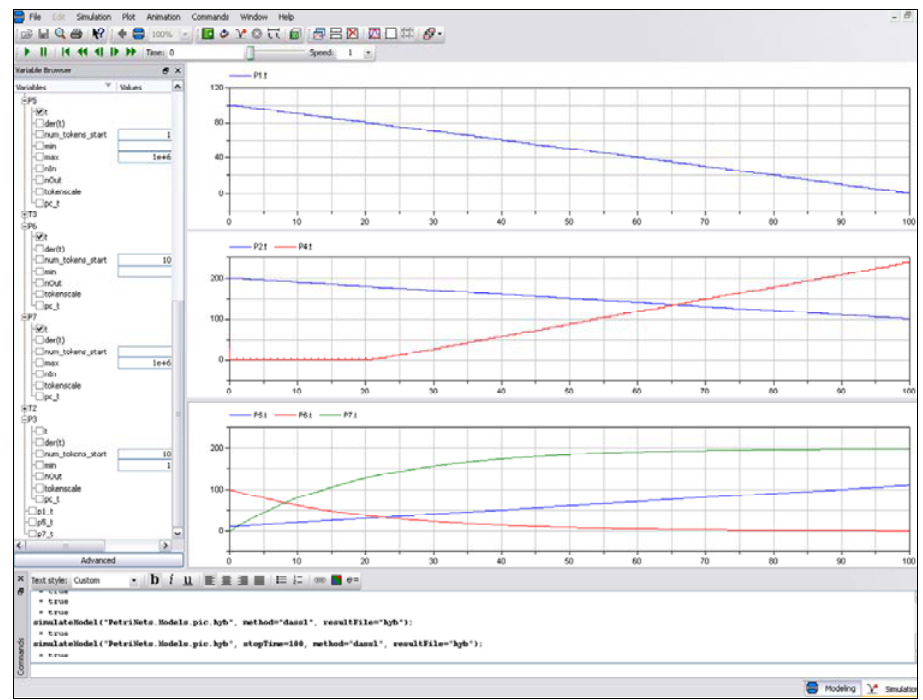
Figure 18: The representation of the simulation results by several plots with selected Token